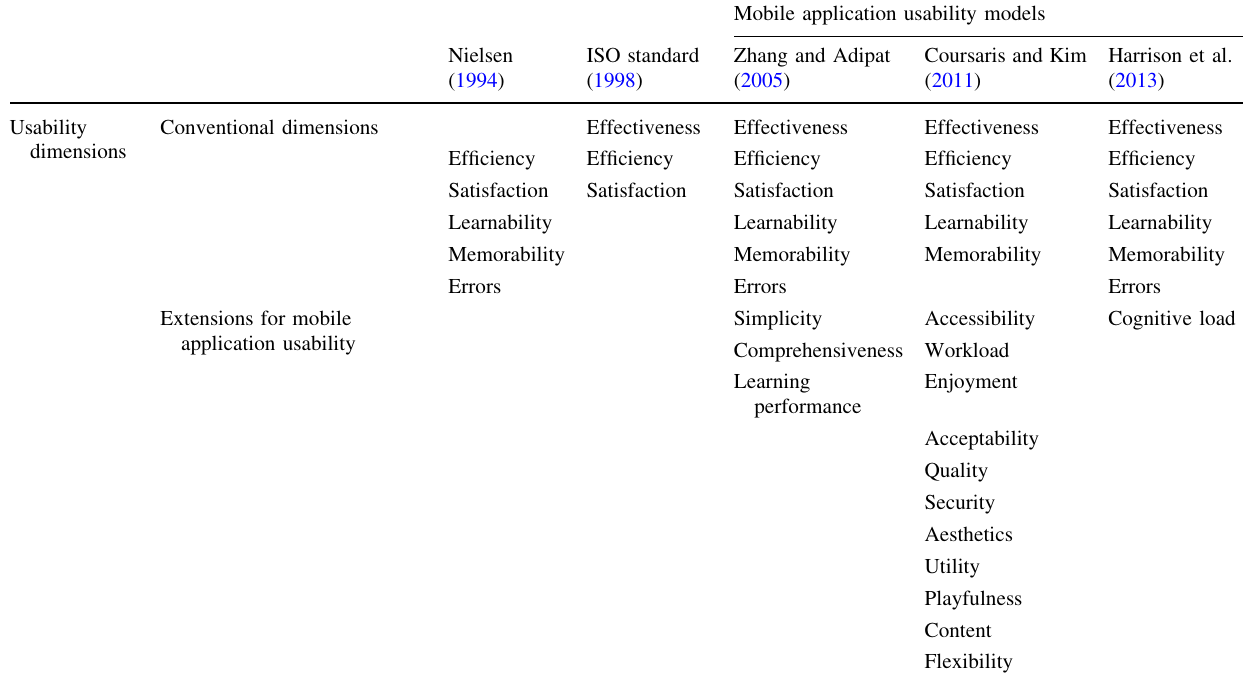
Table 1 Summary of usability dimensions from various usability